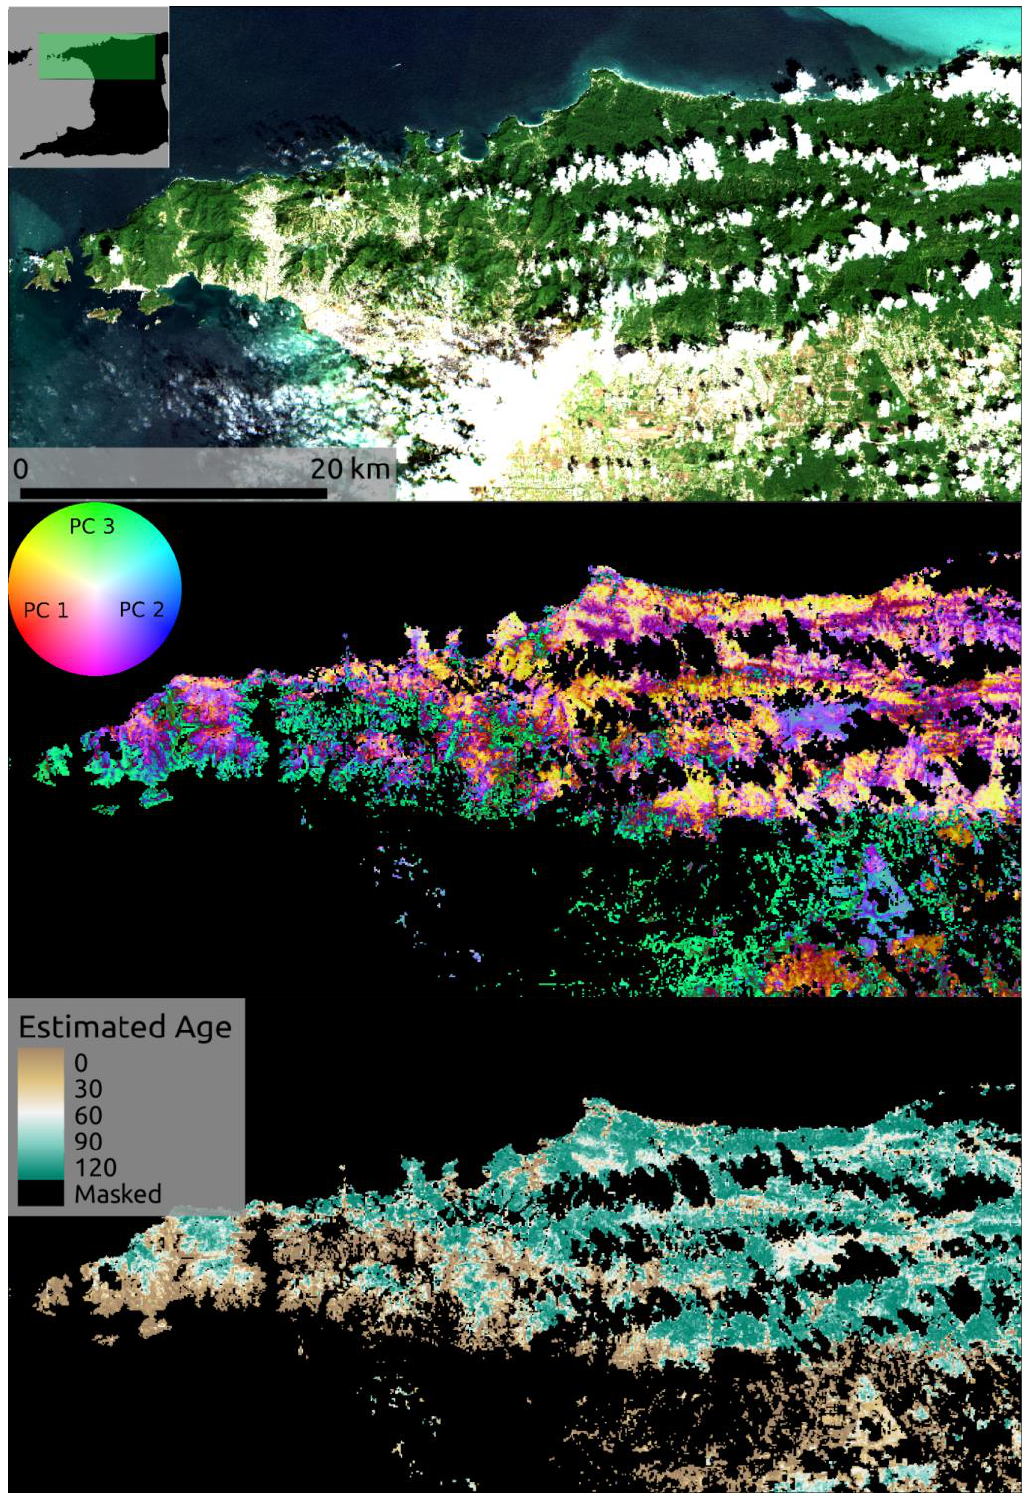
Figure 9. RGB composite from S2 image acquired in 13 February 2019 and used to compute diversity metrics ( top ), dissimilarity map based on the RGB representation of the three components of the PCoA derived from dissimilarity analysis ( middle ), and age estimates based on the first Principal Coordinate ( bottom ).